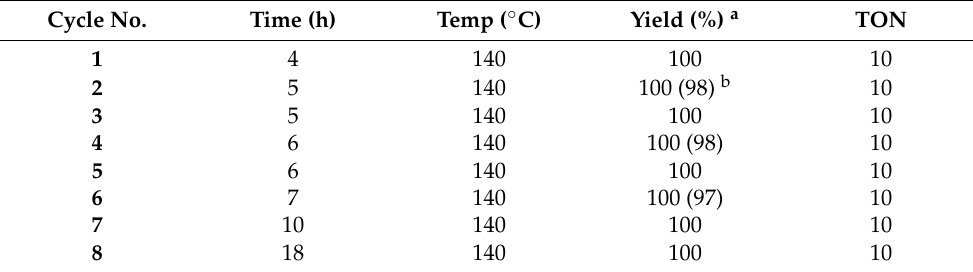
Table 6. Recycling results of 2a -catalyzed Stille reaction of 4-cyanobromobenzene ( 9 ) and vinyl tributyltin ( 3 ) under the thermomorphic